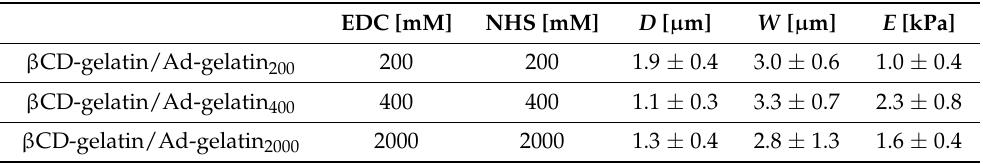
Table 2. Thickness D , width W , and Young’s modulus E of post-conjugated β CD-gelatin/Ad-gelatin fibers crosslinked at different concentrations of EDC and NHS ( N =